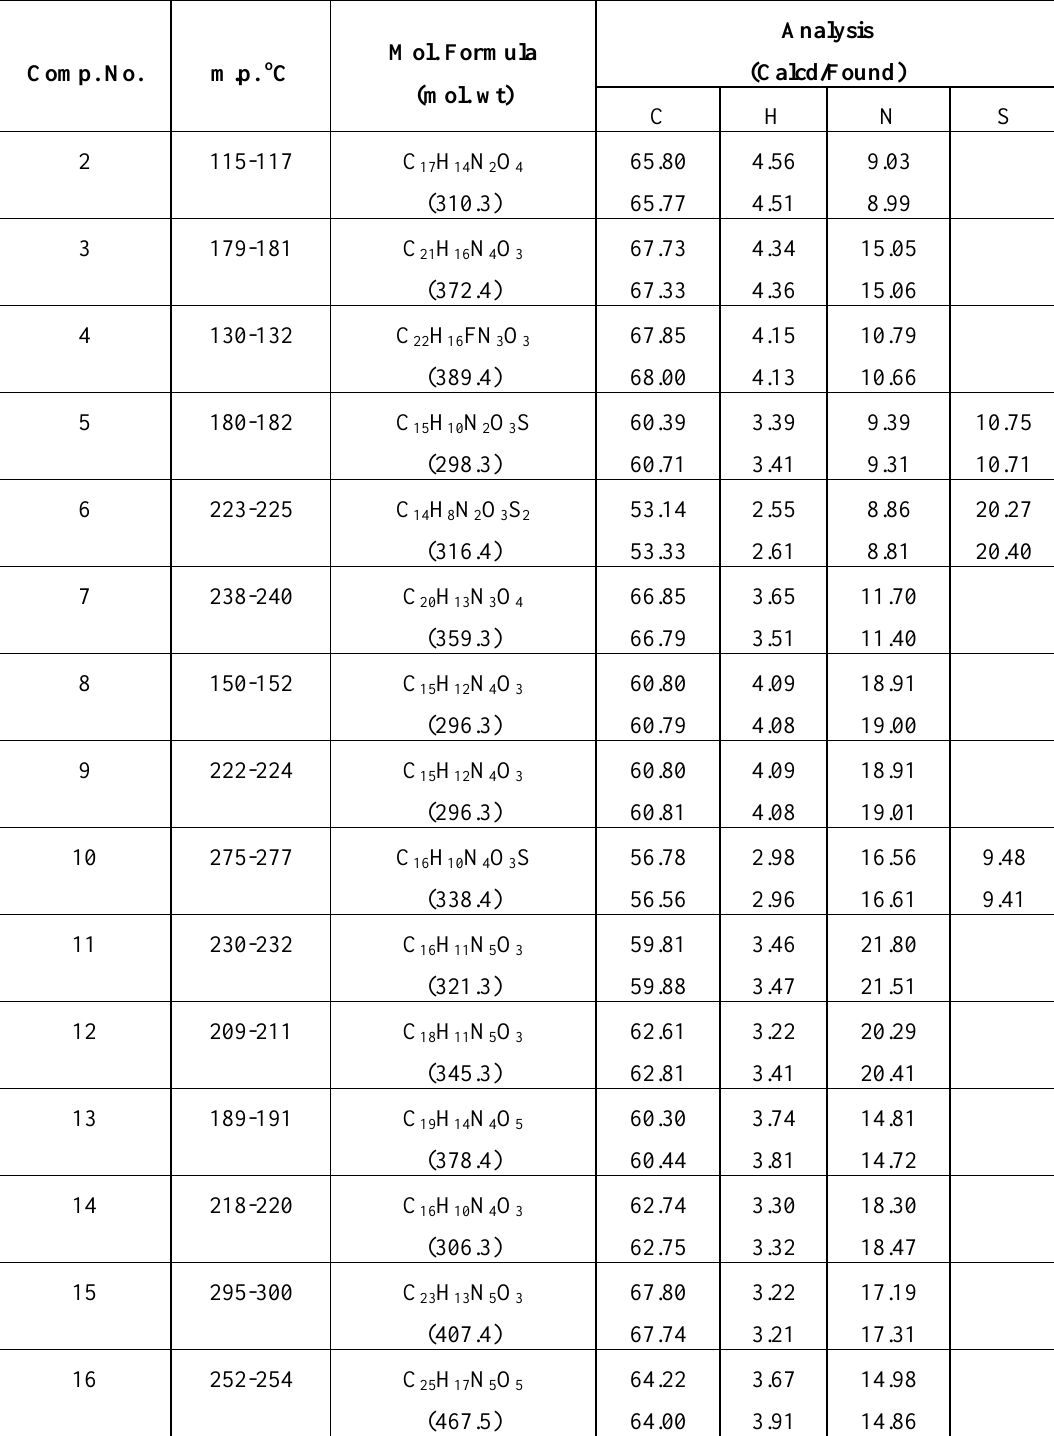
Table 1. Physical data for the selected compounds.